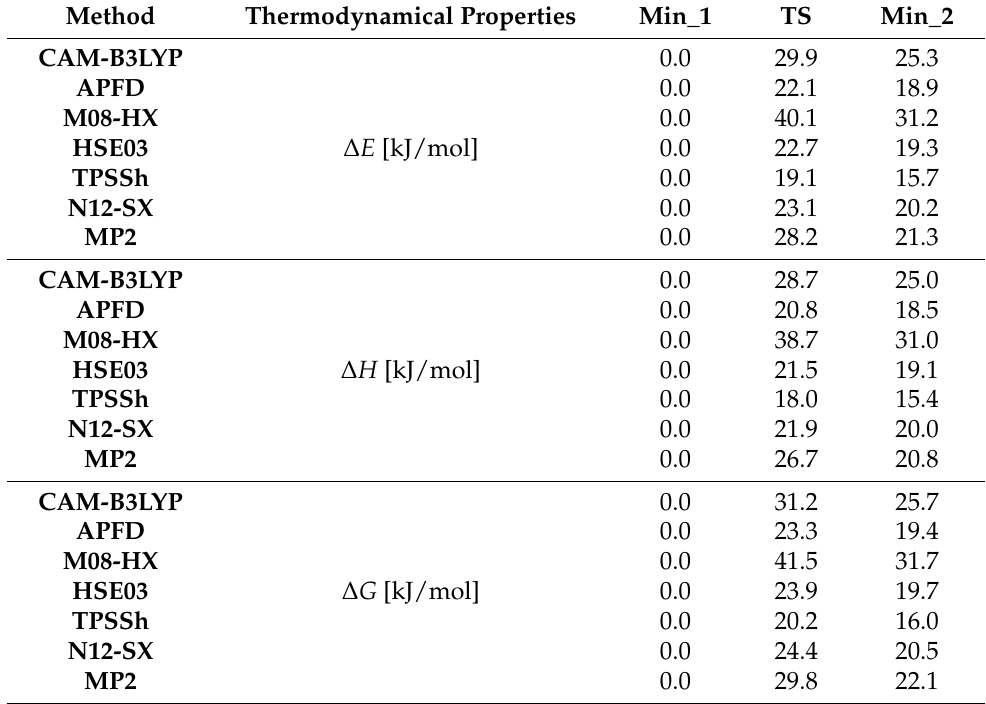
Table 1. Thermodynamic reaction path for the proton motion in the hydrogen bridge of Naphthazarin (asynchronous, single proton transfer path), for details see Figure 3. The energy characteristics was obtained based on DFT and MP2 method with 6-311+G(2d,2p) basis